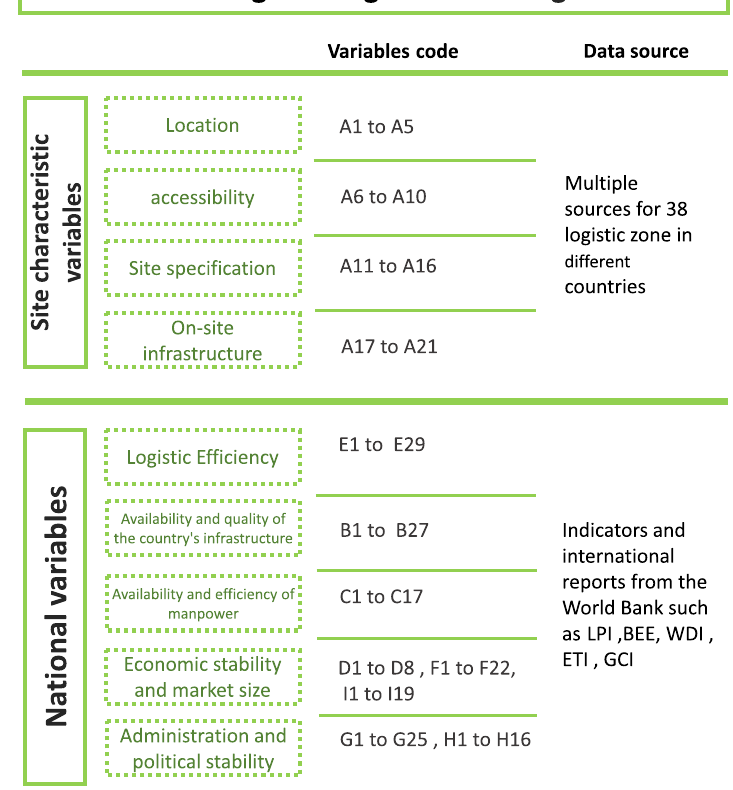
Fig. 4 Data gathering and encoding